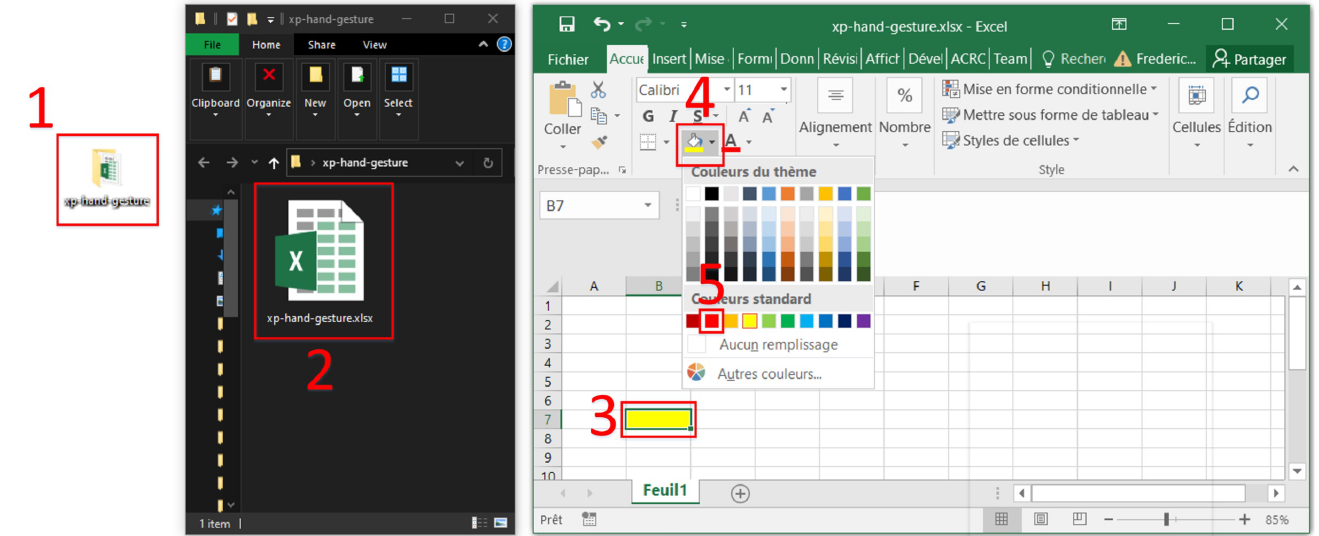
Figure 11. Five steps to execute with both the hand gesture interface and the AssystMouse to complete the first task.